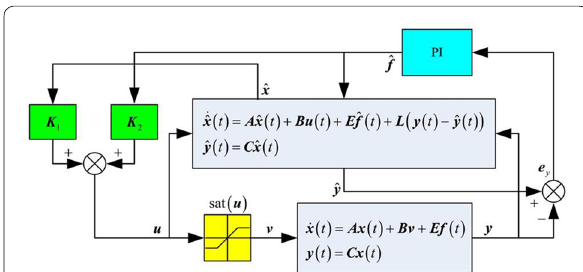
Figure 21 Block diagram of closed-loop system